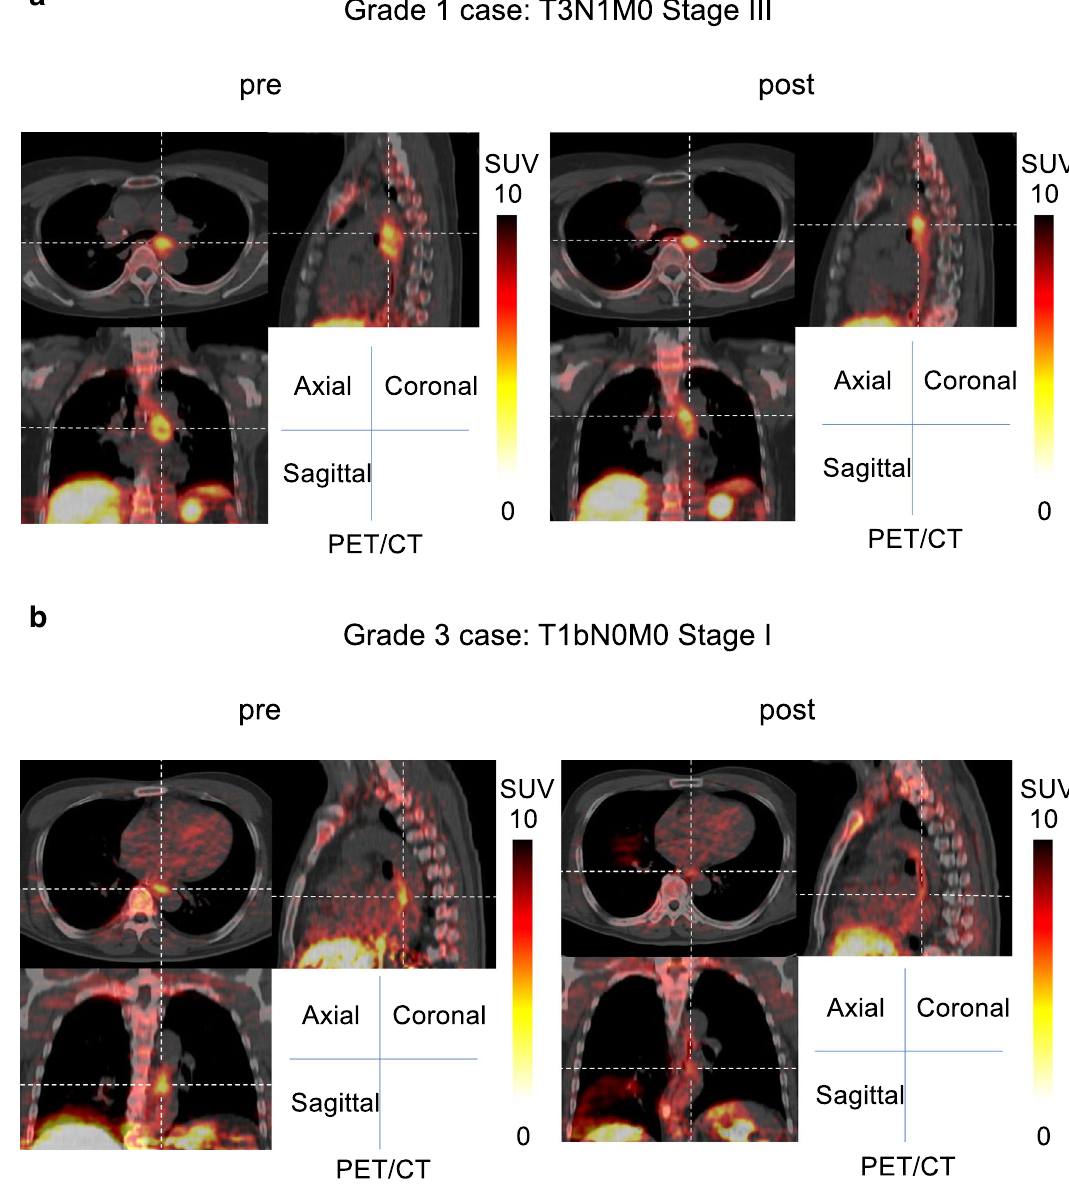
Figure 4. Representative cases. ( a ) Grade 1 cases: T3N1M0, stage III. ( b ) Grade 3 cases: T1bN0M0, stage